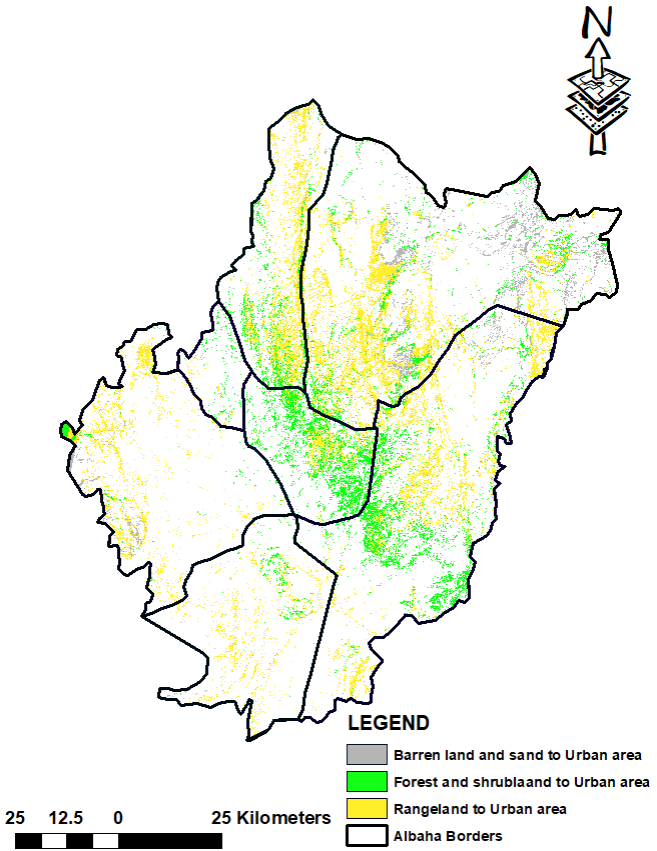
Figure 10. Spatial mapping of the converted the various land cover to built-up areas at El Baha region between 1984 – 2021.